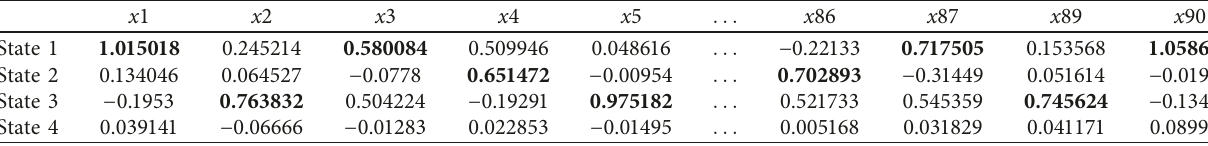
Table 10: Cross-validation set identification rate.